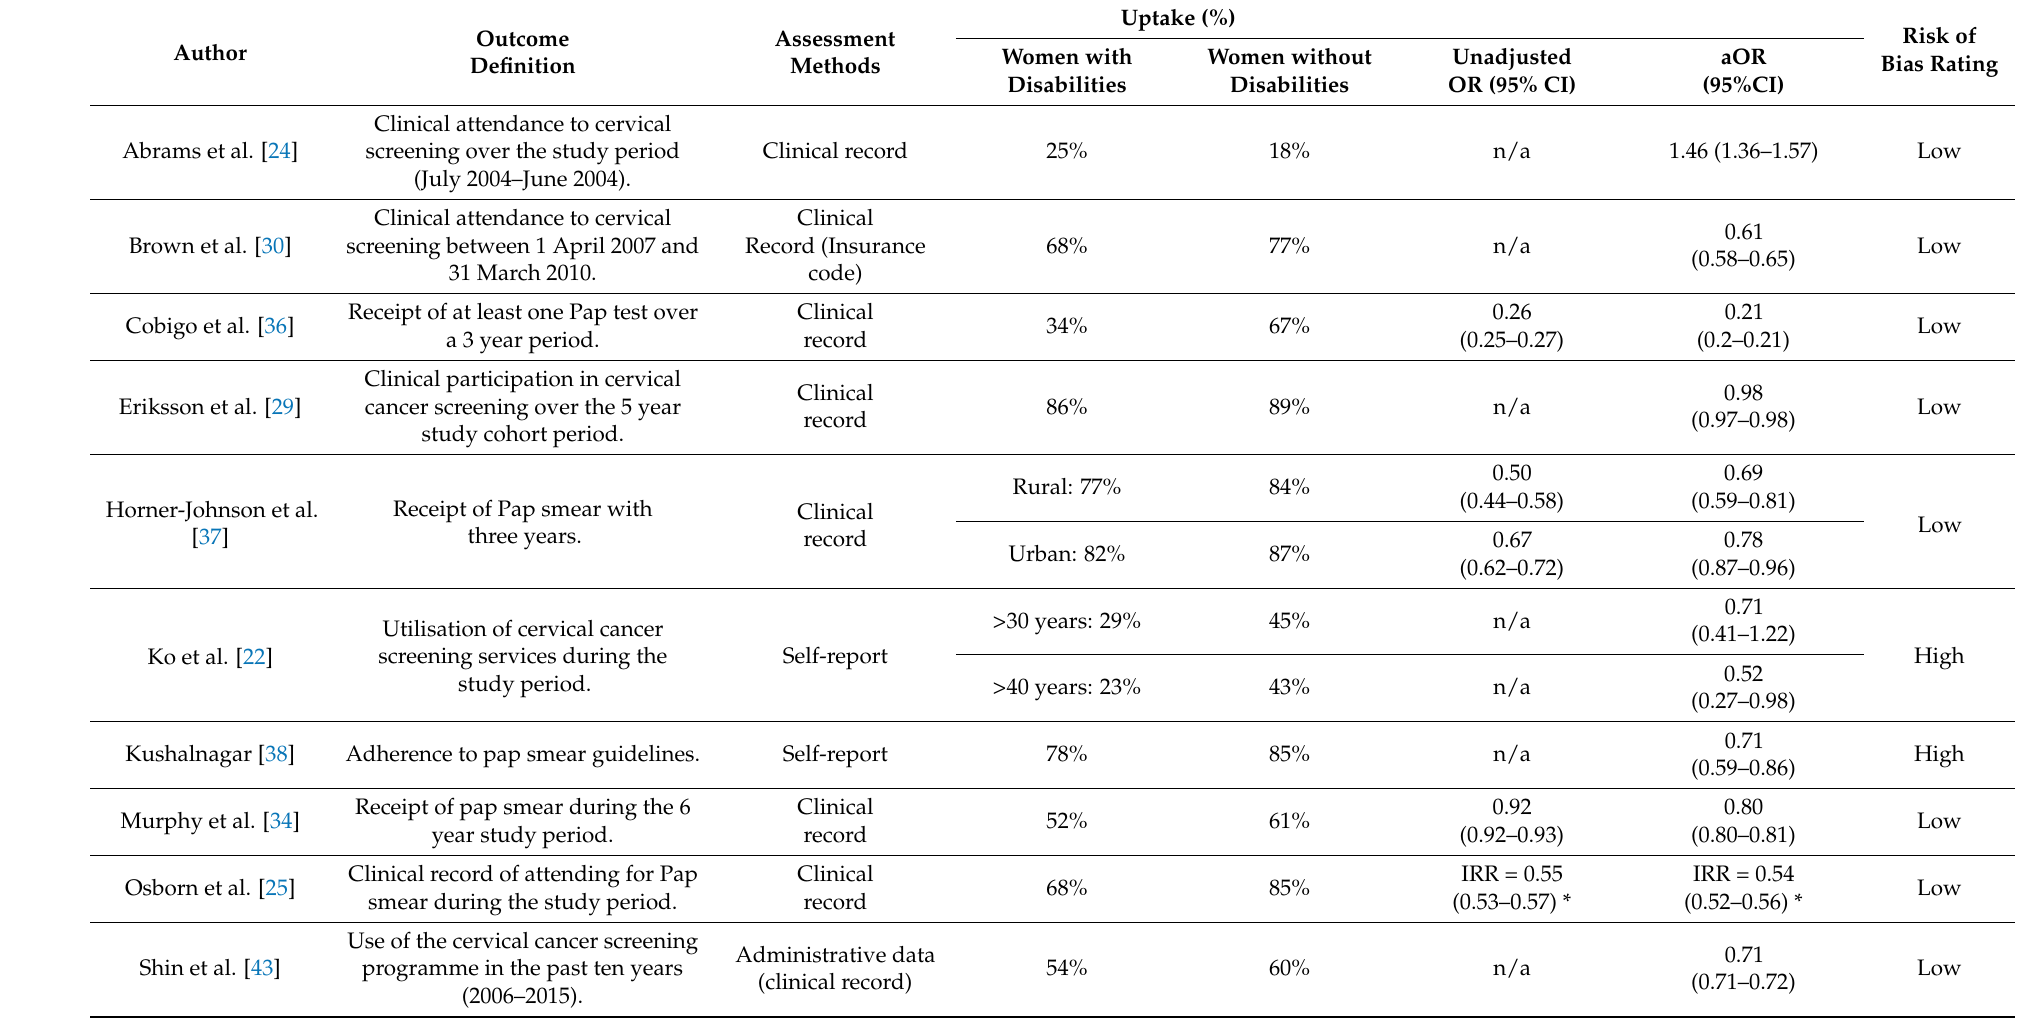
Table 3. Details on outcome measurement and estimate of association between presence of any type of disability in women and cervical cancer